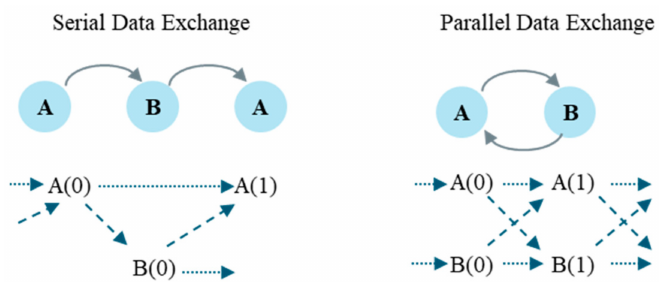
Figure 4. Standard data exchange options between two simulators, A and